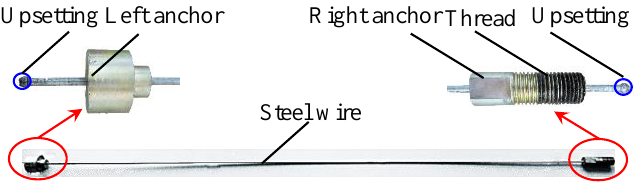
Figure 9. The tested steel wires specimen.